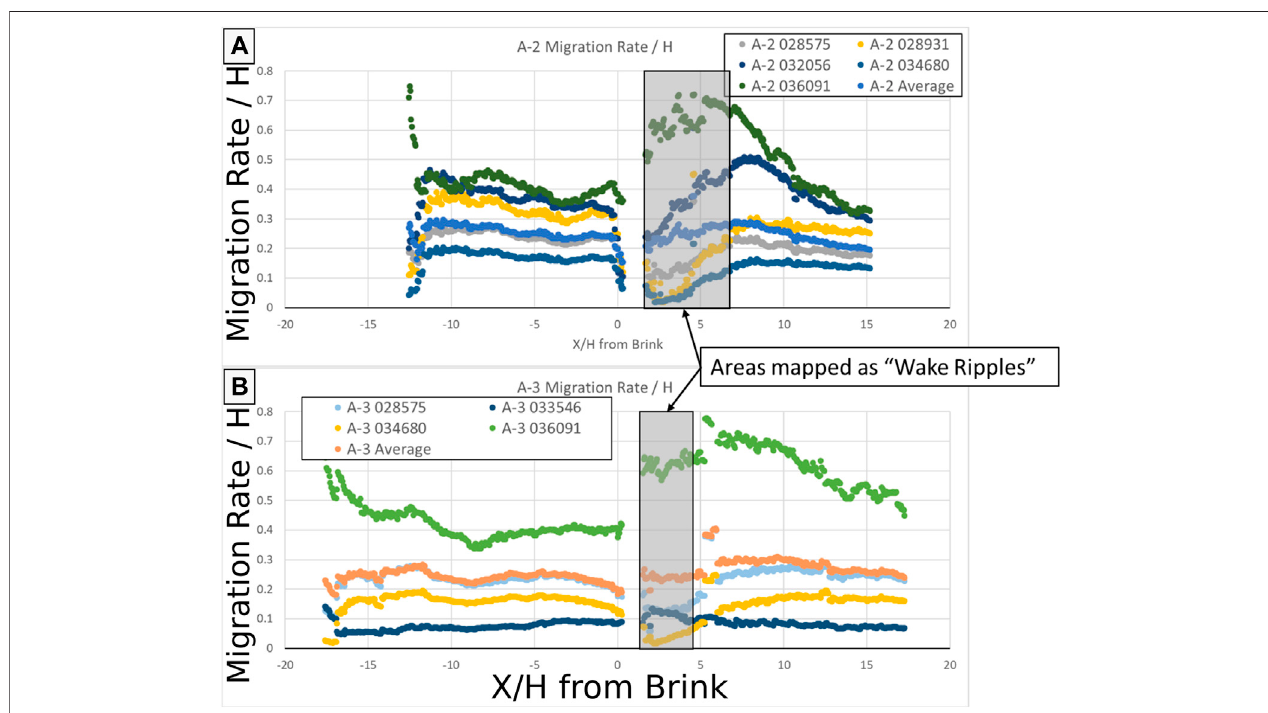
FIGURE10| R/HformultipletimestepsforTransectsA-2 (A) andA-3 (B) .The “ 028575 ” mapsarethedatashownin Figures6 , 8 ,andtheotherdatawerechosen as representative of the diversity of lee-wake patterns seen in each case. In both cases, the pattern of R/H in map 028575 was commonly repeated in other maps, although with a variable average